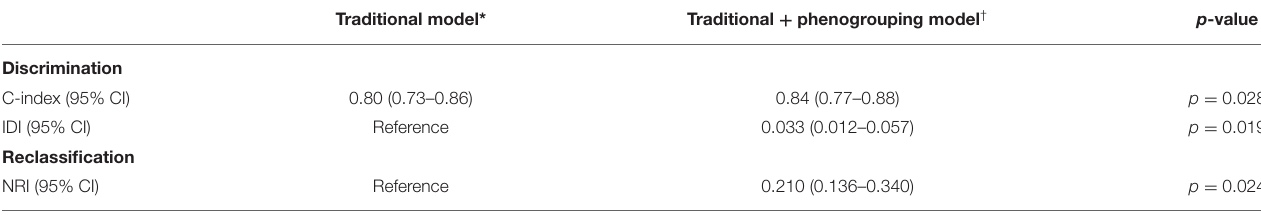
TABLE 3 | Discrimination and reclassification of the traditional model with and without phenogroups for prediction of